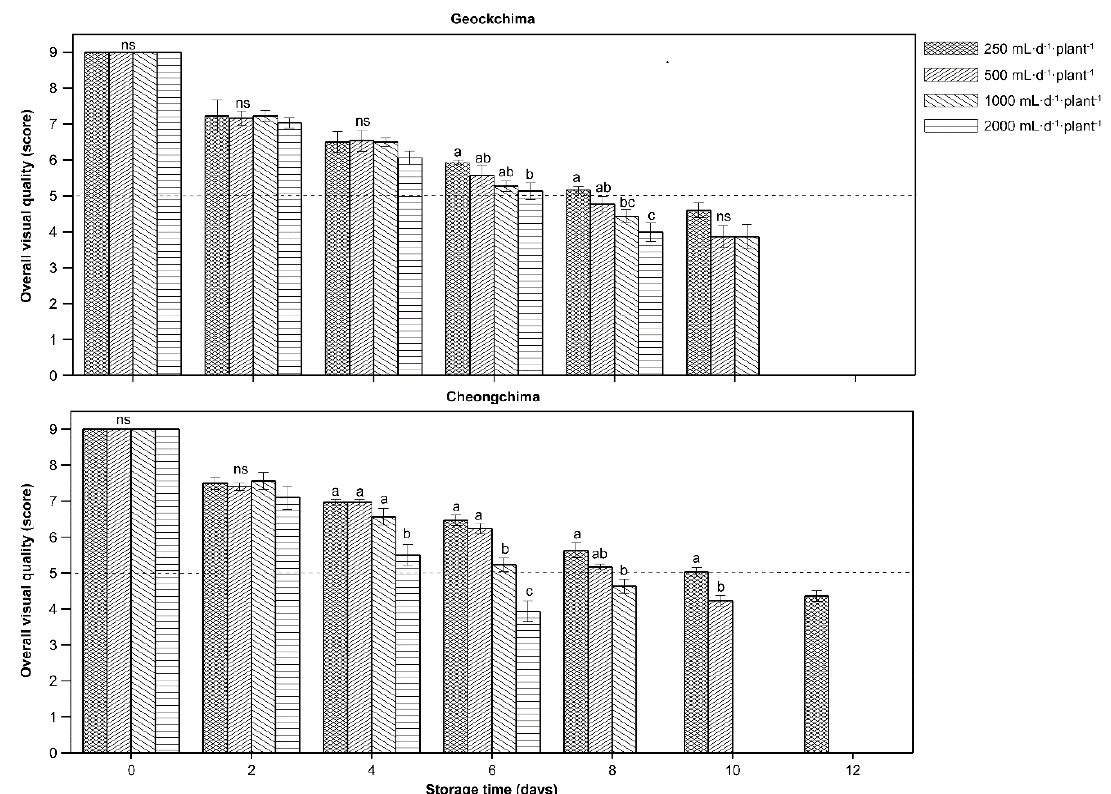
Figure 4. The overall visual quality scores of leaf lettuce cultivars, Geockchima and Cheongchima, grown in perlite culture with different amounts of the nutrient solution during storage at 7 °C (the dotted line corresponds to the limit of acceptability). Mean values in each evaluation day with different lowercase letters are significantly different according to Duncan’s multiple range test ( p ≤ 0.05), ns = non-significant.